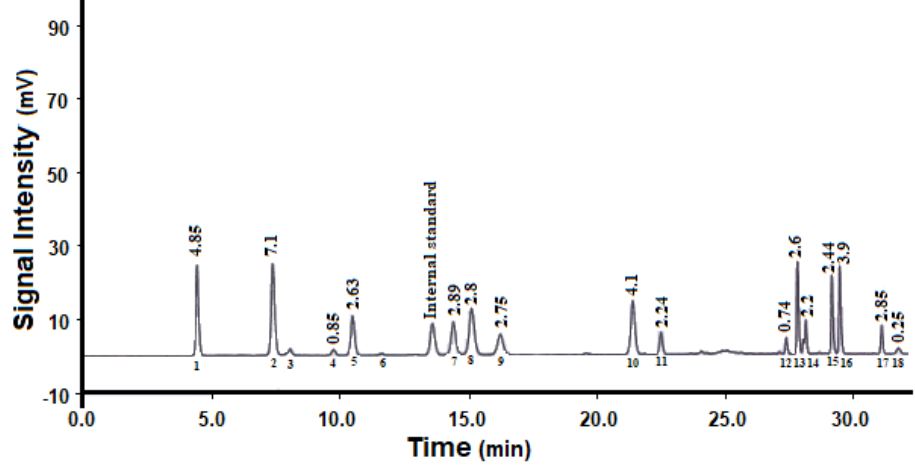
Figure 1. Amino acid composition of pepsin-hydrolyzed peptides: (1) aspartic acid; (2) glutamic acid; (3) asparagine; (4) histidine; (5) serine; (6) glutamine; (7) arginine; (8) glycine; (9) threonine; (10) alanine; (11) tyrosine; (12) methionine; (13) valine; (14) phenylalanine; (15) isoleucine; (16) leucine; (17) lysine; (18) tryptophan.